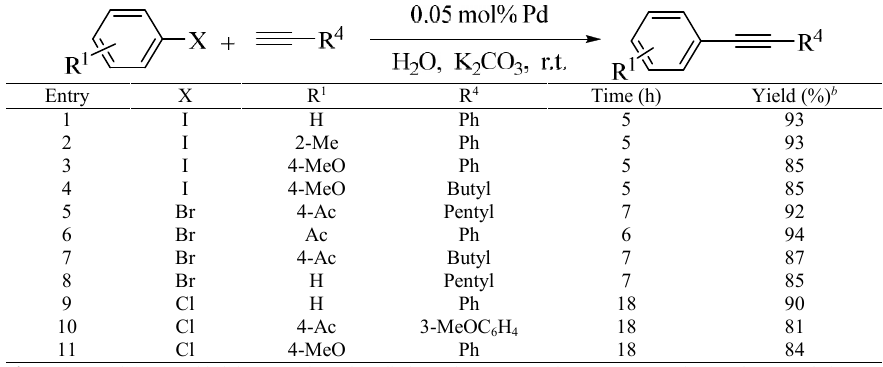
Table 6. Sonogashira cross-coupling of aryl halides with aromatic or aliphatic alkynes catalyzed by MNP/HPG-CA/Pd a